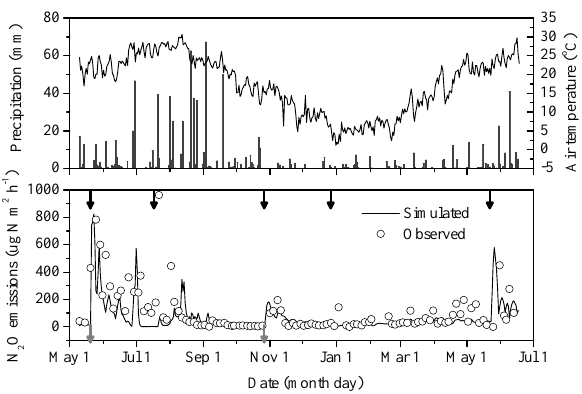
Fig. 6. Precipitation and air temperature (a) , simulated and ob- served nitrous oxide emissions (b) from typical forestland in the Yanting watershed during 2005. Modified from Wang et al.,